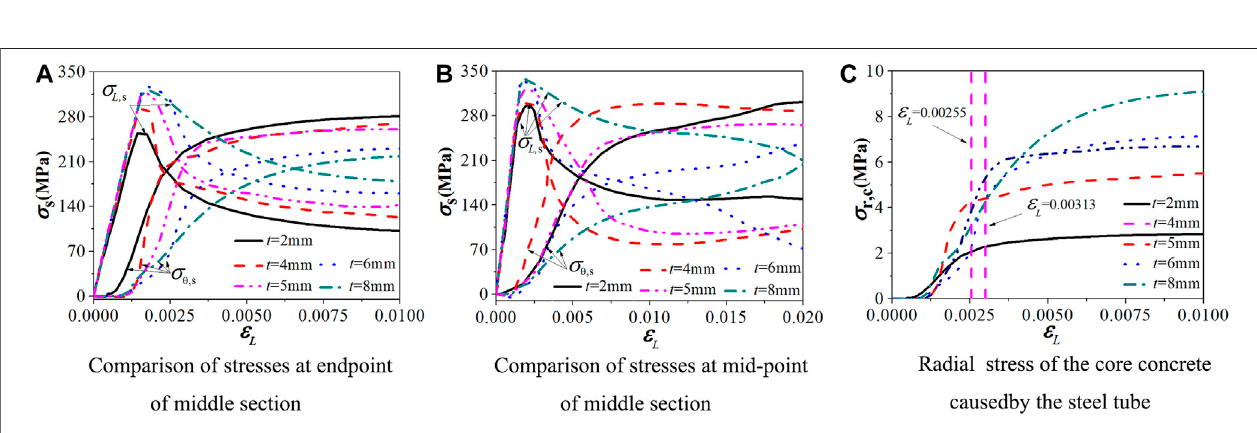
FIGURE 8 | Comparisons of mechanical behavior of specimens with different steel